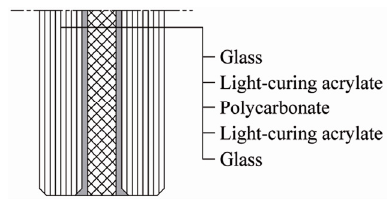
Figure 2: Cross-section of glass-polycarbonate